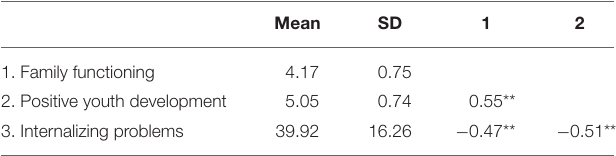
TABLE 1 | Descriptive statistics and correlation analysis results of each variable ( n = 11,865).